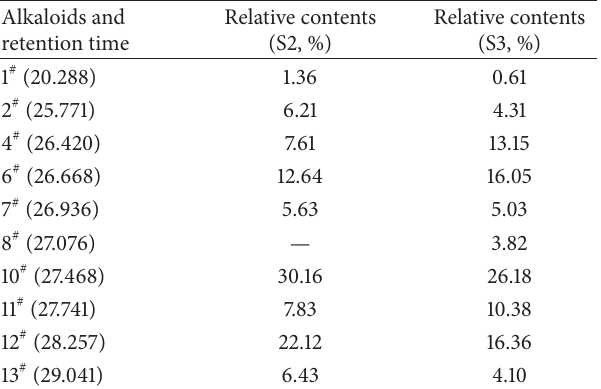
Table 2: The relative contents of alkaloids in the crude RC samples S2 and